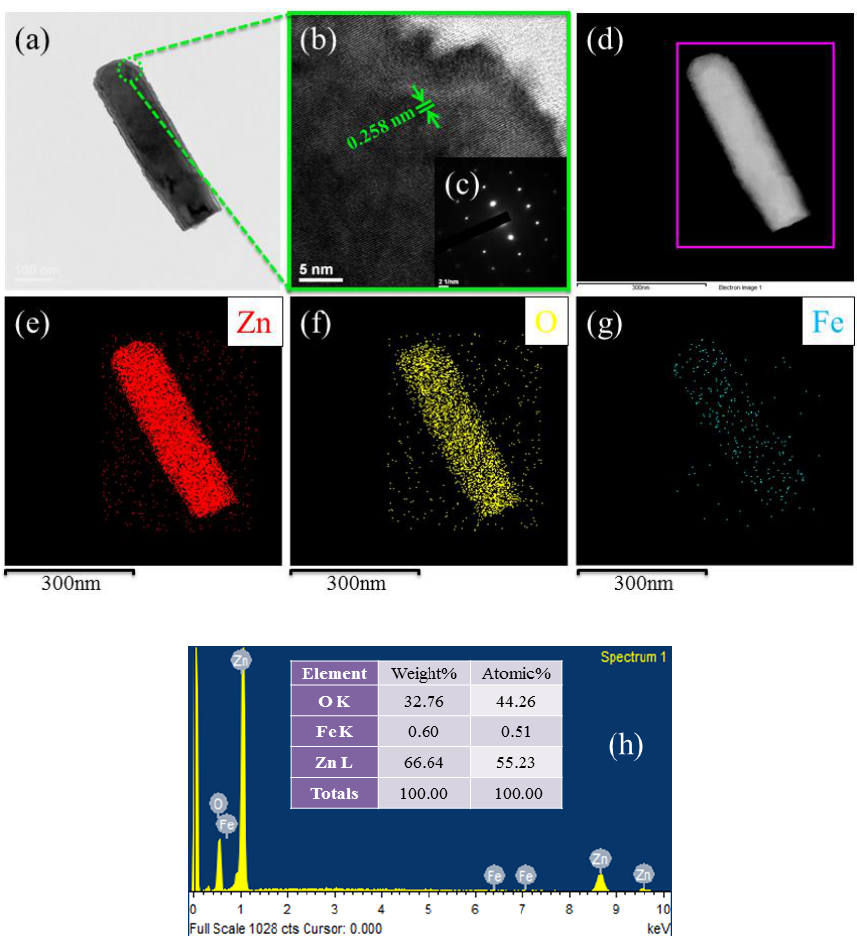
Figure 5. ( a ) Low-magnification BF TEM micrograph of FZO NR sample grown on substrate. ( b ) HR-TEM image of tip of the FZO NRs, where inset ( c ) corresponds to the SAED pattern of FZO NRs. ( d – g ) TEM elemental mapping images of as-prepared FZO NR structure for the selected region, displaying the existence of Zn (red), O (yellow), and Fe (cyan). ( h ) EDX spectra of as-synthesized FZO NR arrays.